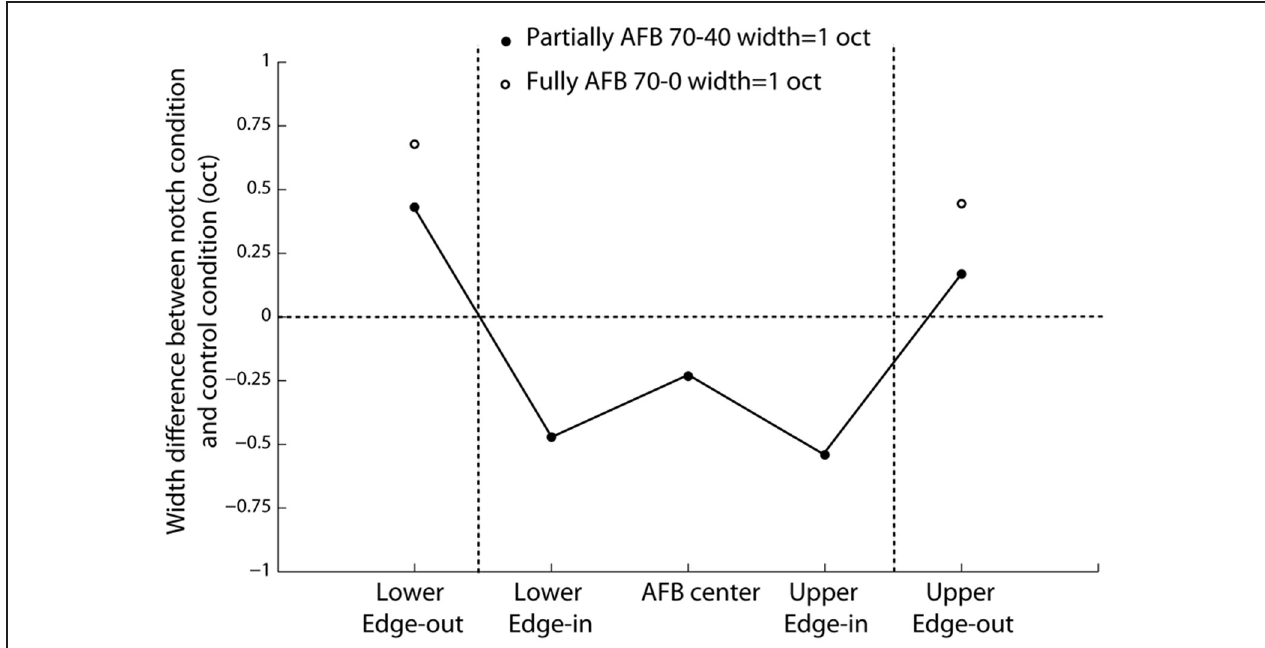
FIGURE 8 | Difference (in octaves) in the width of the “excitation patterns” between the two AFB conditions (one-octave and fully AFB) and the control conditions (40-dB within the AFB and 70-dB outside the